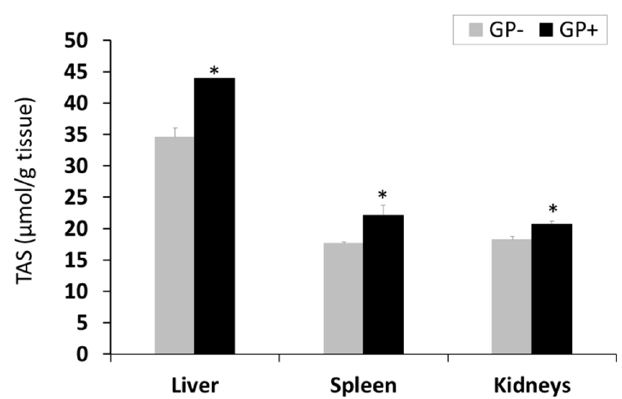
Figure 2. Total antioxidant status (μmol/g tissue) as determined by the total antioxidant status (TAS) assay, in the liver, spleen and kidneys samples (n = 10); * = statistically significant when GP− was compared with